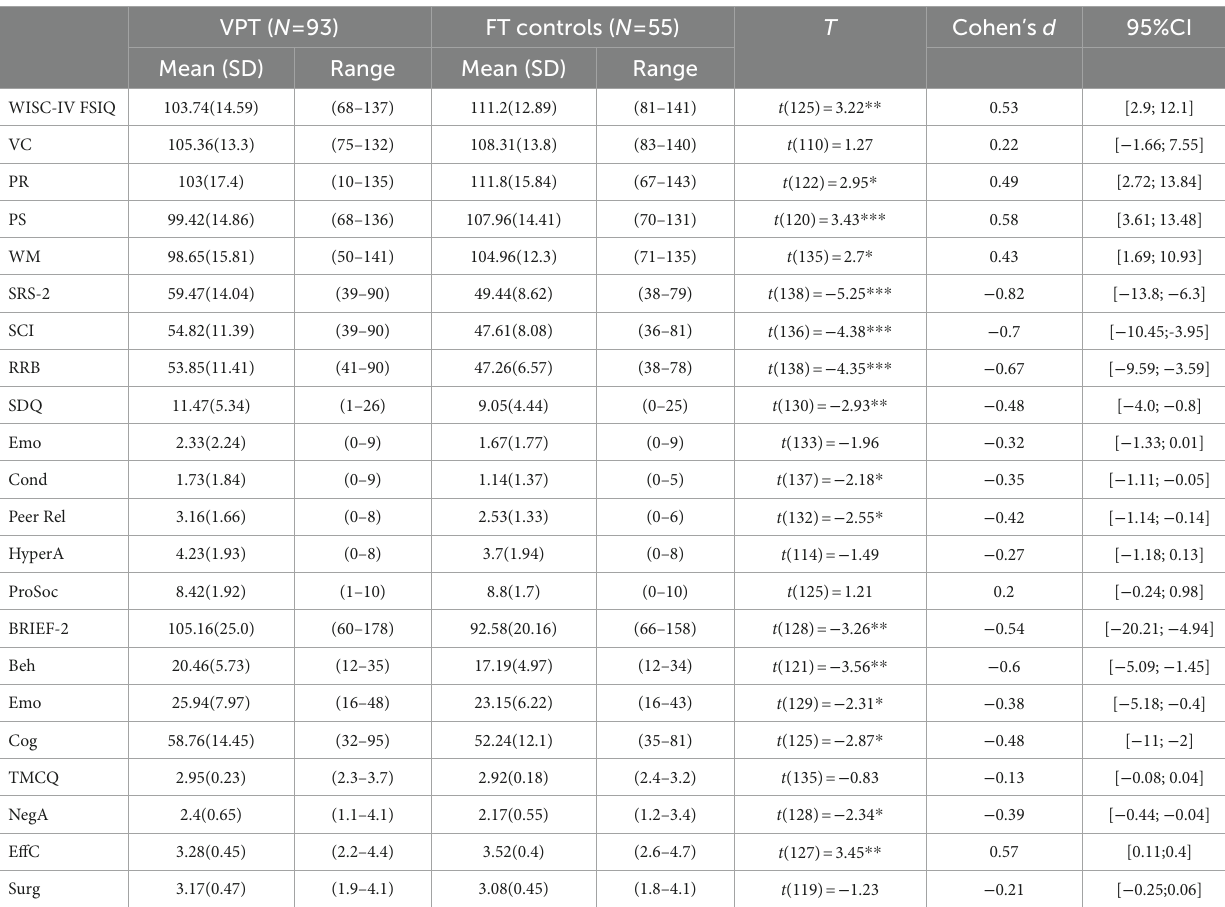
TABLE 2 Descriptive statistics for all outcome measure in the VPT and FT control